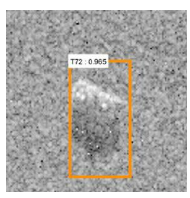
Figure 11. Interpretation result after Non-Maximum Suppression